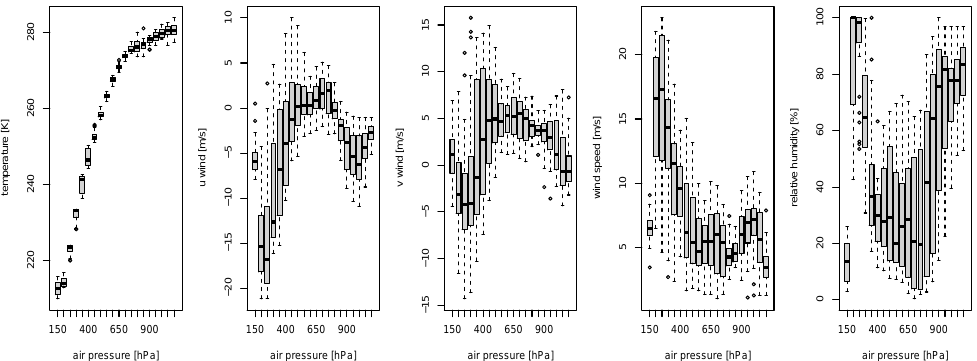
Figure 4. Boxplots of three variables grouped by air pressure with a snapshot on 4th of September 2018 and longitude ranges from 15E to 20E, latitude from 35N to